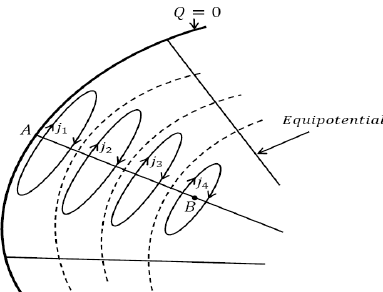
Figure 8: Equivalence of function 𝑄 and small loop currents densities